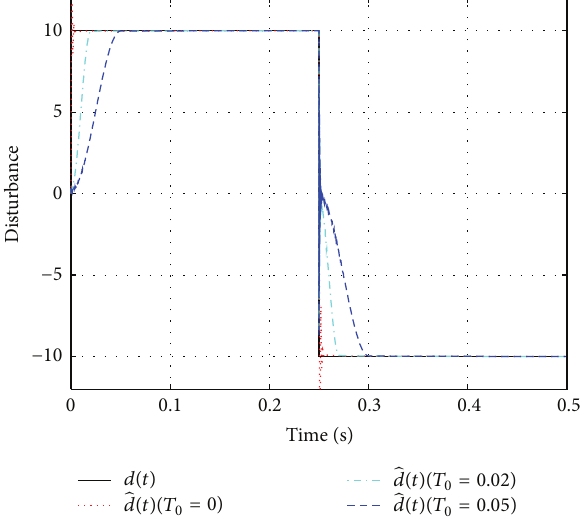
Figure 6: Results of Example 2 with FDOB0 and FDOB1.